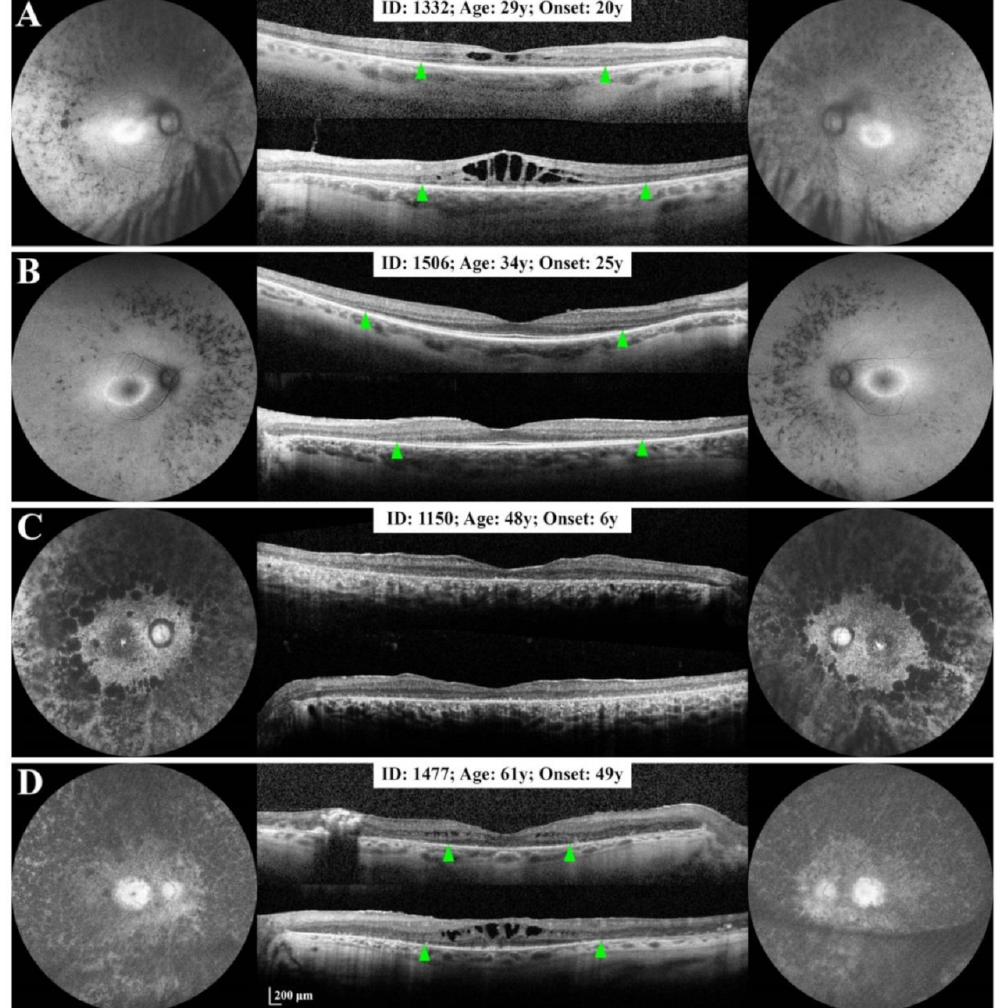
Figure 2. Ultra widefield ( A , D ) and 55 ◦ short-wavelength ( B , C ) autofluorescence imaging and spectral-domain